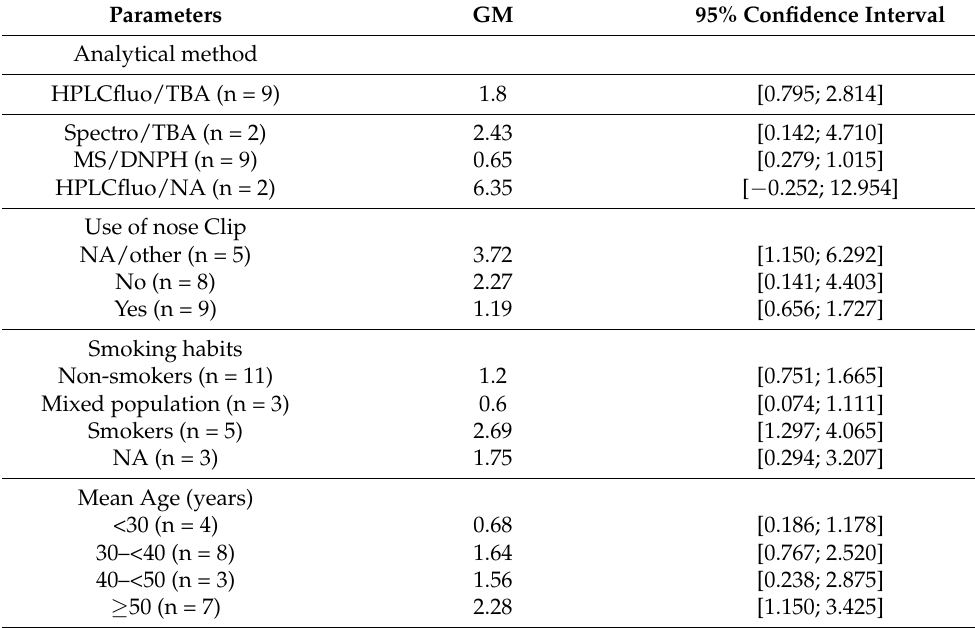
Table 3. Predicted concentrations of MDA (ng/mL) in EBC using the linear